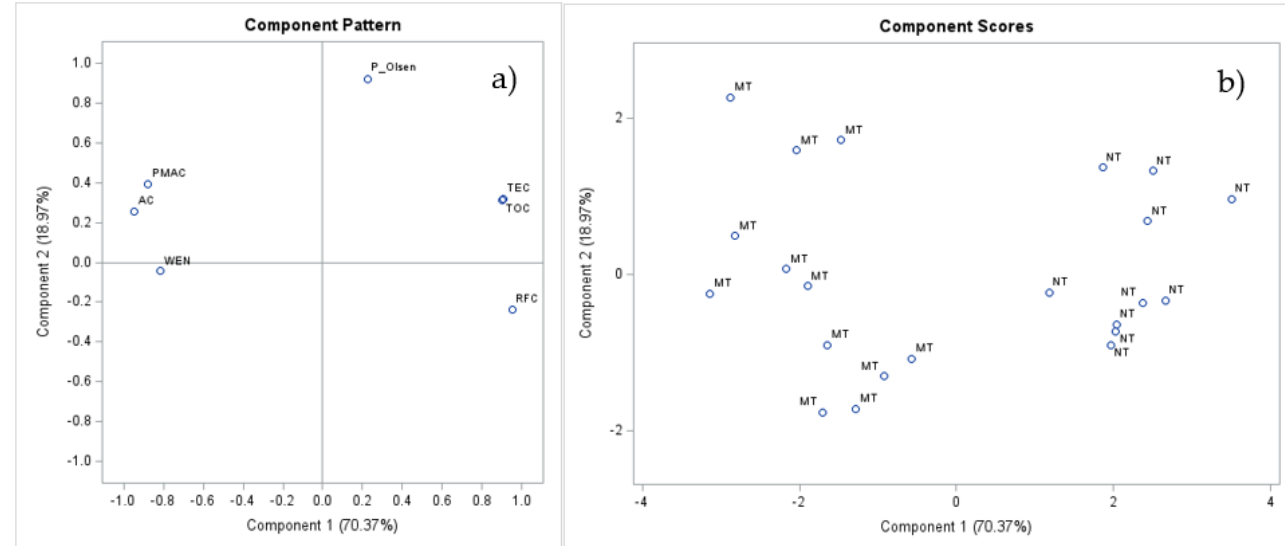
Figure 4. Plots of the component loadings ( a ) and scores ( b ) of the first two principal components extracted in the analysis carried out on the indicators selected from results of PCA, SDA, PLS. Variance explained: PC1 = 70.37%; PC2 = 18.97%. MT = minimum tillage; NT = no-tillage. TOC = total organic carbon; TEC = alkali-extractable carbon; WEN = water extractable nitrogen; P_Olsen = Olsen available phosphorus; P MAC = macroporosity; AC = air capacity; RFC = relative field capacity.